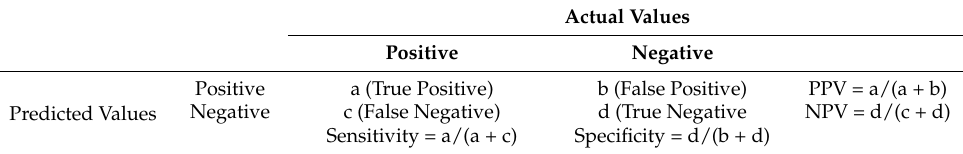
Table 1. The definition of the machine-learning model evaluation parameters. PPV, positive predictive value; NPV, negative predictive